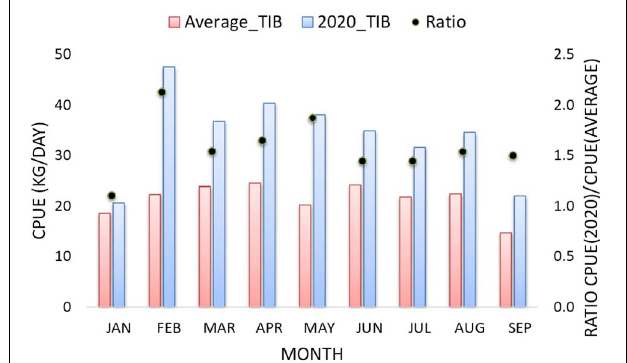
FIGURE 4 | Comparison of nominal 2020 monthly CPUE for the TIB sector with the average computed over the preceding period 2004–2019. The second vertical axis shows the ratio of the 2020 monthly CPUE relative to the average pattern to highlight the anomalous pattern observed at the start of